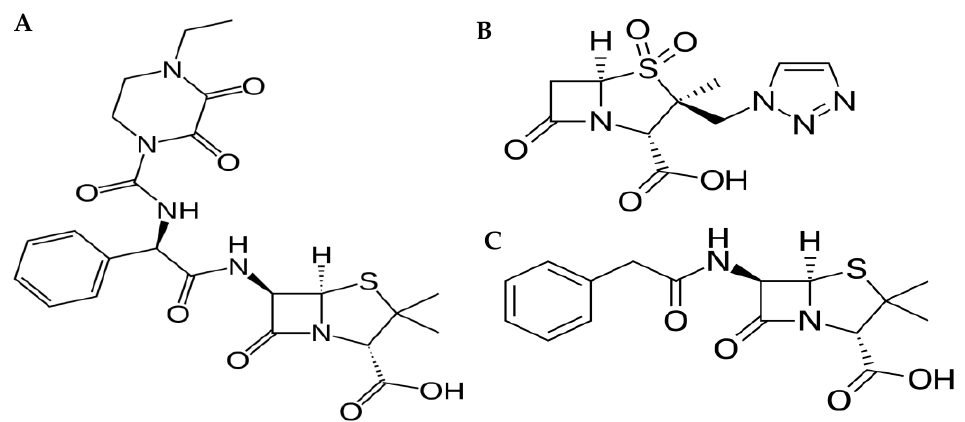
Figure 1. Chemical structures of ( A ) Piperacillin; ( B ) Tazobactam; and ( C ) Penicillin G (internal standard).